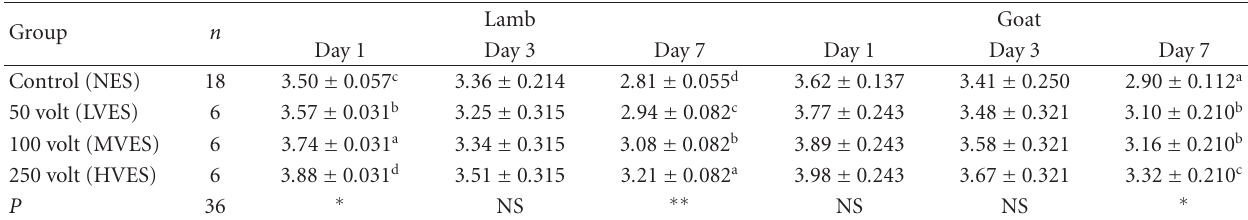
Table 3: Mean and standard errors of water-holding capacity (WHC) values in lamb and goat meat during aging at 4 ◦ C (%). Lamb Goat Group n Control (NES)